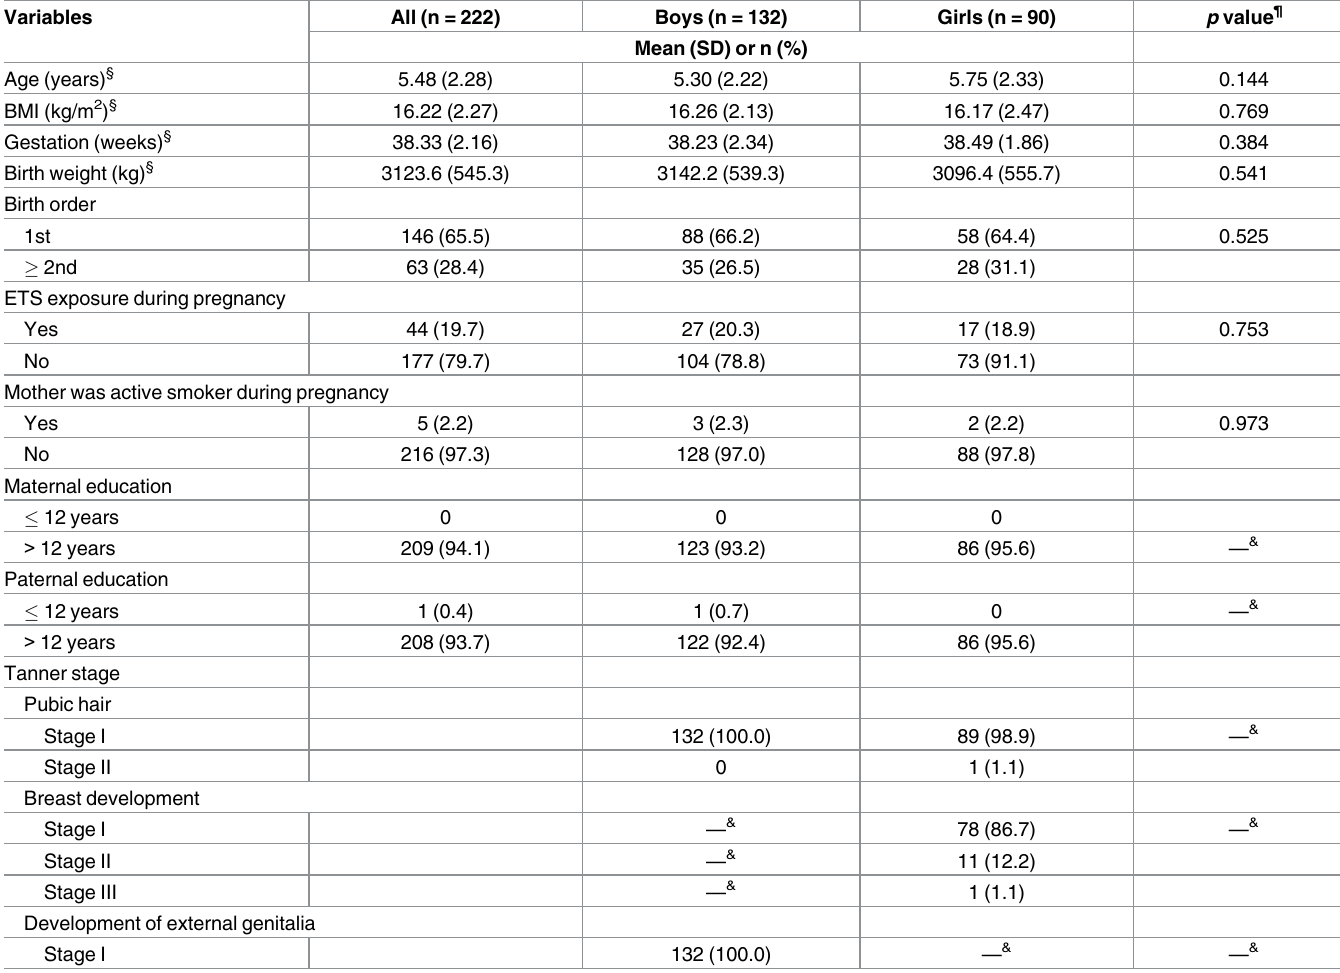
Table 1. Statistical description of participants’ characteristics by